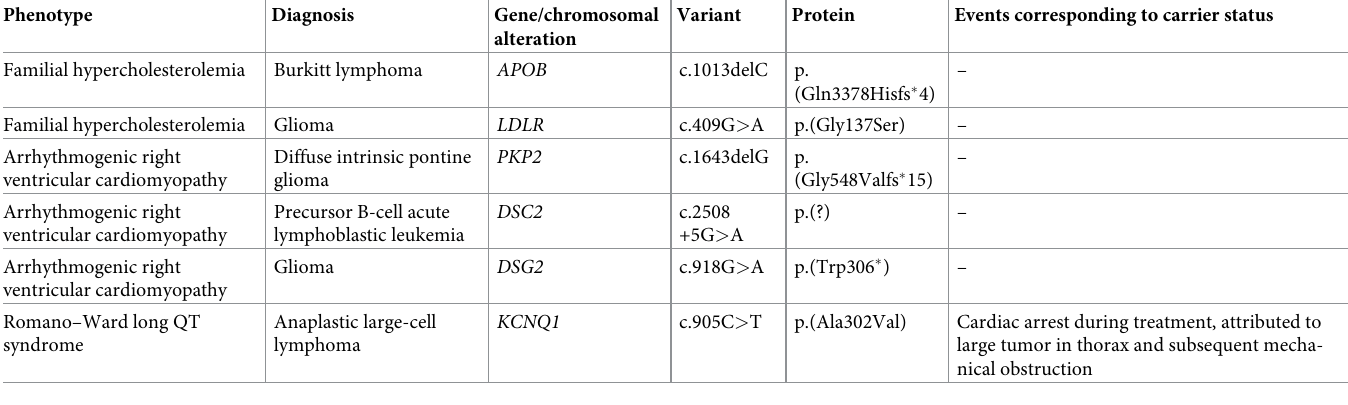
Table 11. Pathogenic/likely pathogenic variants in genes deemed ‘actionable’ by the American College of Medical